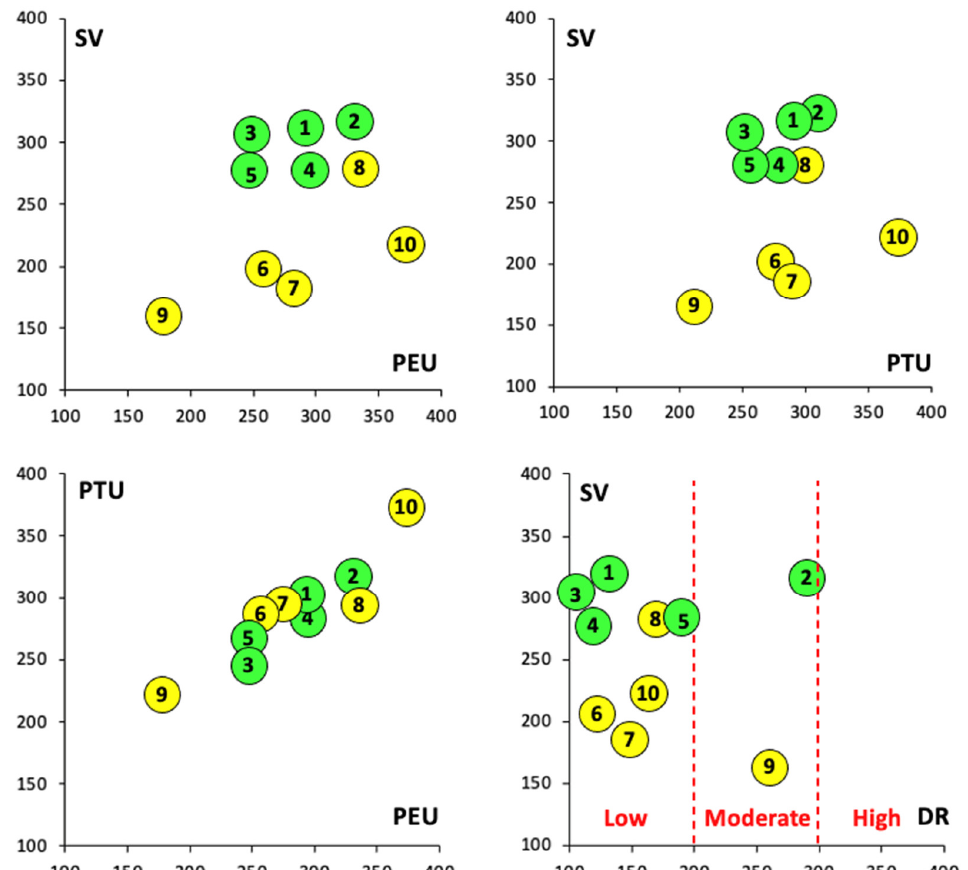
Figure 8. Comparison between the scientific value (SV), potential educational value (PEU), potential touristic value (PTU), and degradation risk (DR) of the geosites included in the Italian inventory by ISPRA [4] (green) and the other geosites (yellow) selected for this study. In the DR graph, the risk classes proposed by [7] are also reported.